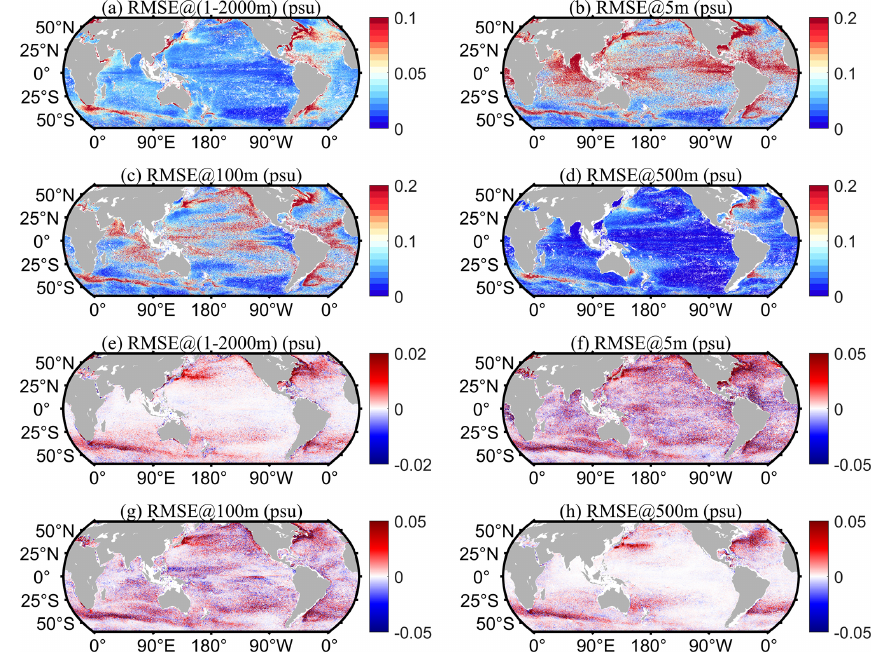
Figure 10. Geographical distribution of RMSE: (a–d) IAP0.25_RMSE and (e–h) IAP1_RMSE minus IAP0.25_RMSE.